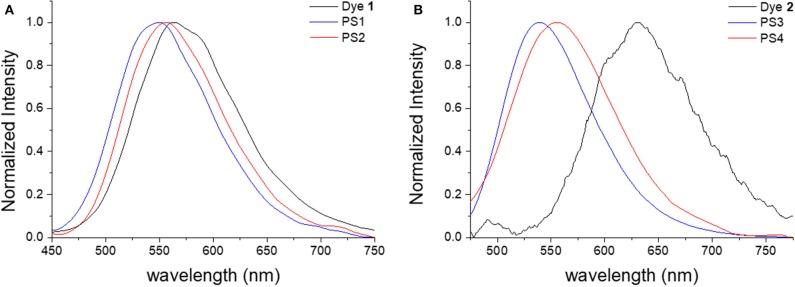
Normalized steady-state emission spectra of free dyes (black) and dye-loaded neutral (blue) and charged (red) nanoparticles in aqueous suspension: (A) dye 1, PS1, and PS2, λex = 340 nm; (B) dye 2, PS3, and PS4, λex = 420 nm.